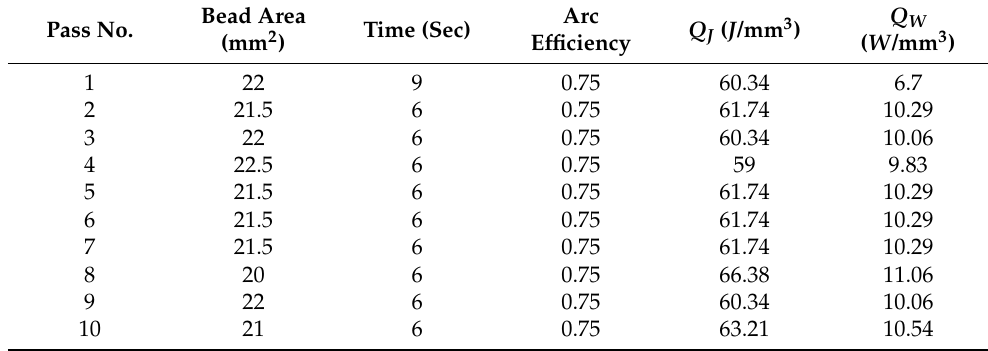
Table 6. Body heat flux parameters for each weld bead. Pass